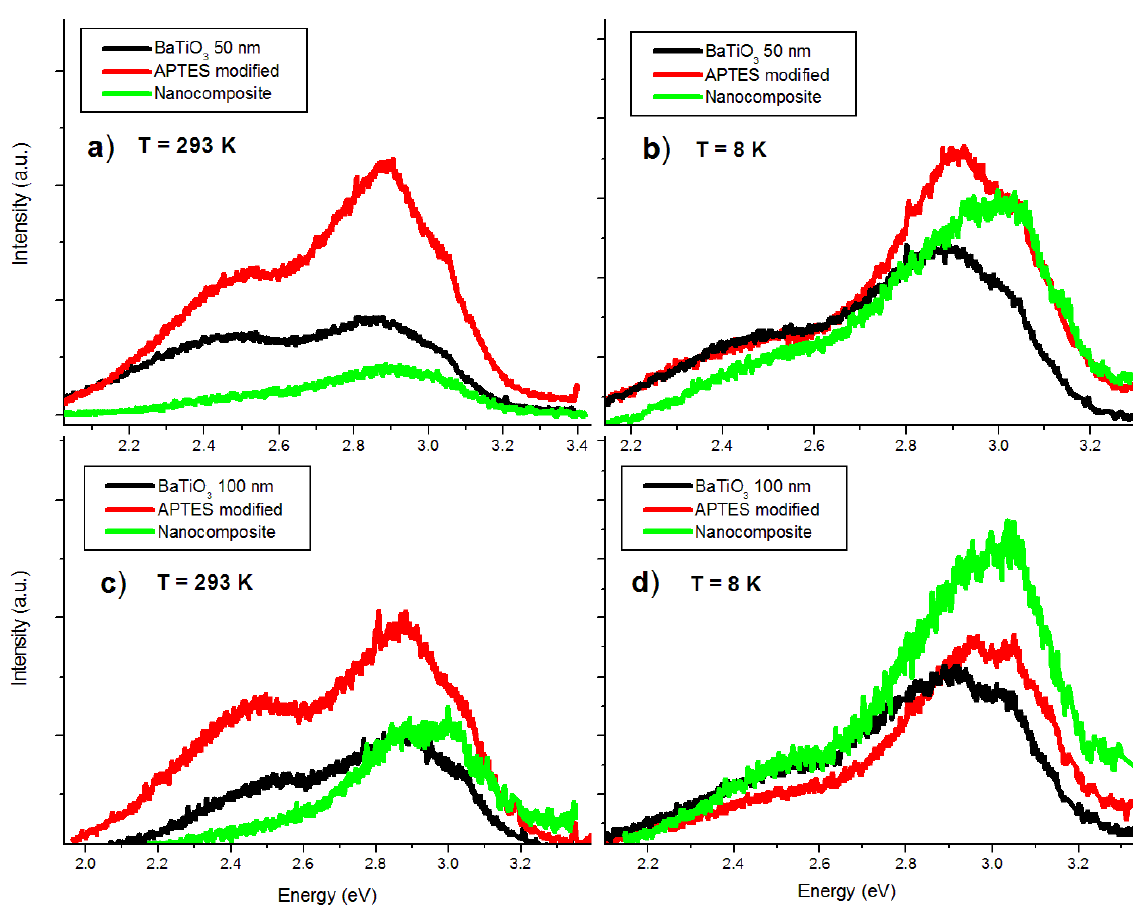
Figure 9. A summary of PL results: ( a ) Comparison of the 50 nm powder, APTES, and nanocomposite at RT; ( b ) Similarly, a comparison at 8 K. Note the enhanced bandgap emission from the nanocomposite; ( c ) Comparison of results from the 100 nm powder at RT; ( d ) 100 nm results at 8